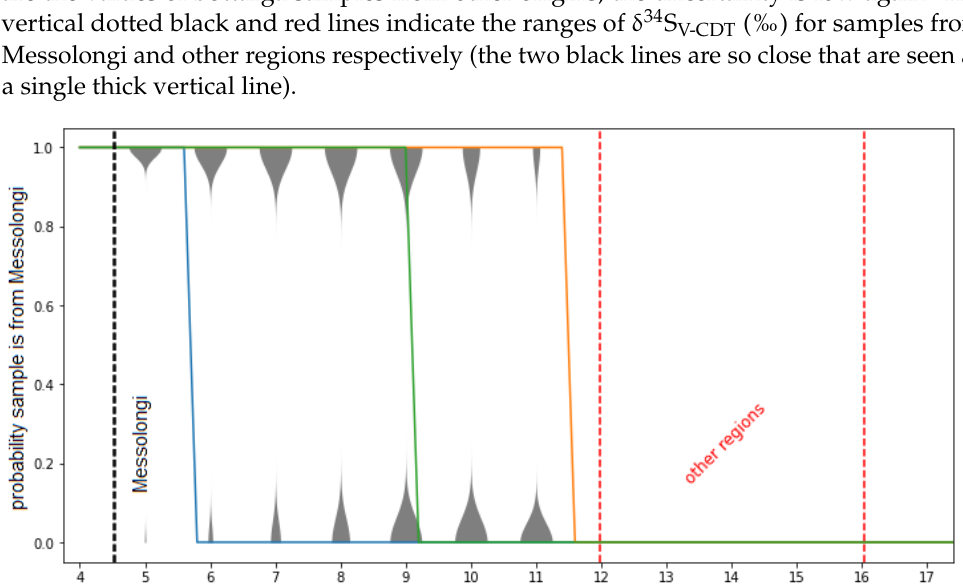
Figure 4. Trace plots of the proposed characterization model.